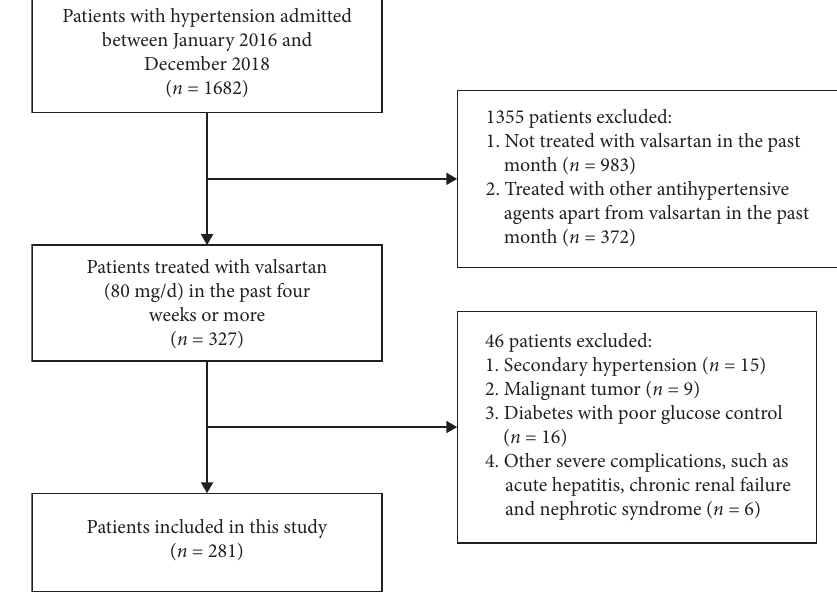
Figure 1: Study population Table 1: Characteristics of hypertensive patients.